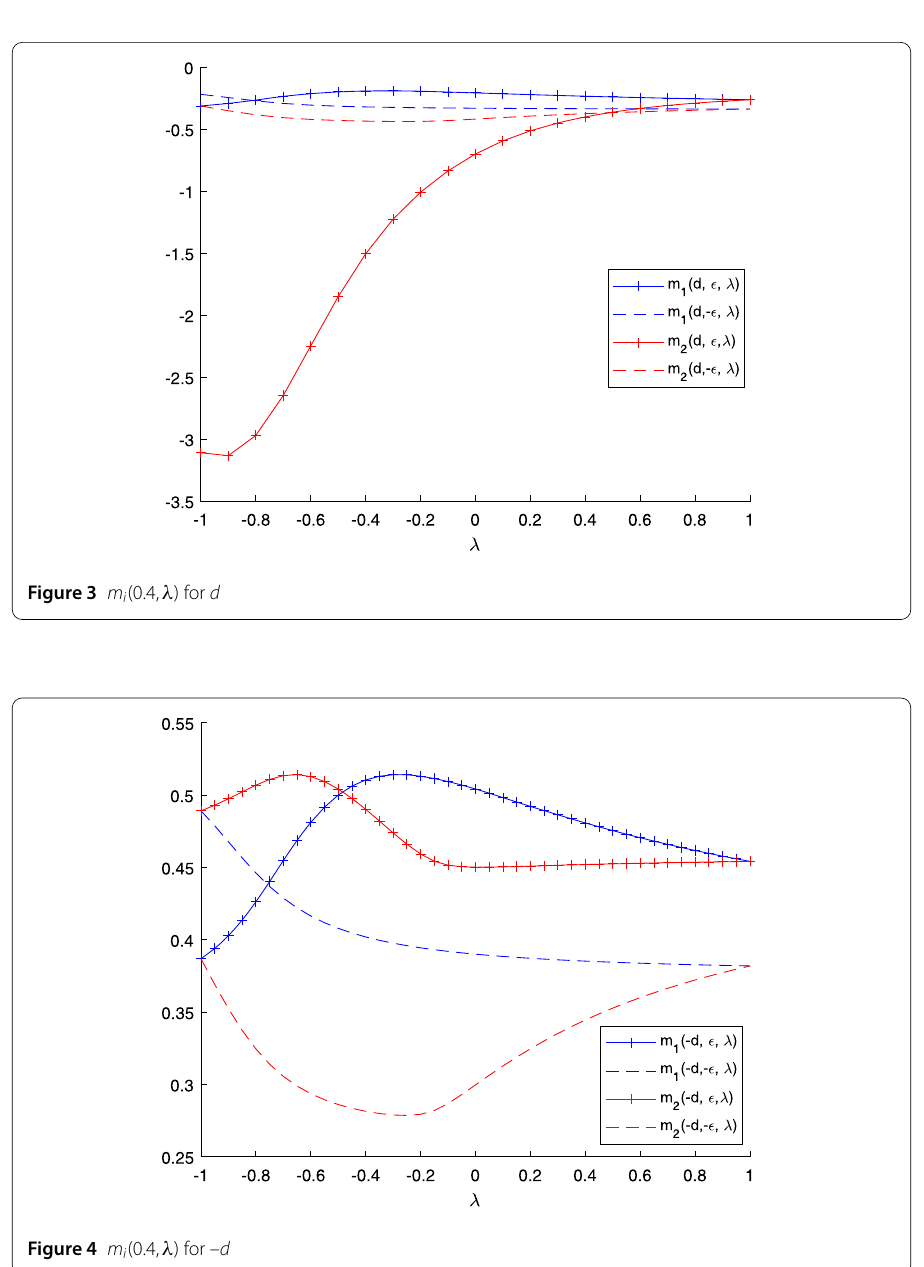
Figure 4 m i (0.4, λ ) for –